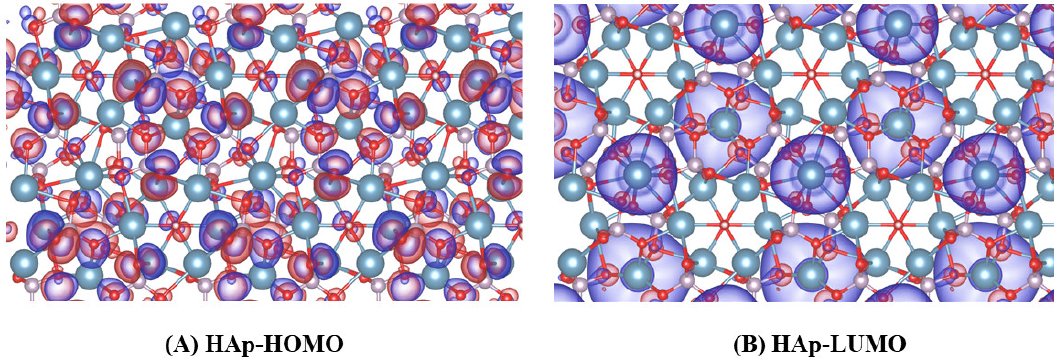
Figure 3. HOMOs and LUMOs of HAp.